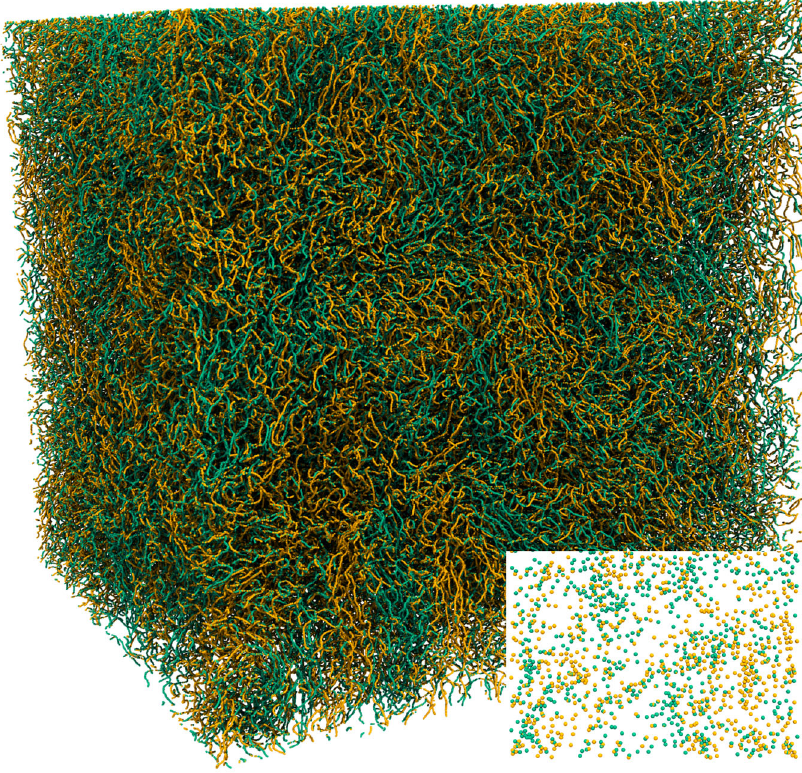
Fig. 1 Visualisation of a quantum turbulent vortex tangle. Instantaneous state obtained from GP simulations using 2048 3 collocation points. Green and yellow colours correspond to opposite orientations of the vortex lines with respect to the vertical direction. The inset shows a horizontal two-dimensional cut of the system. See “ Methods ” for the vortex identi fi cation algorithm.